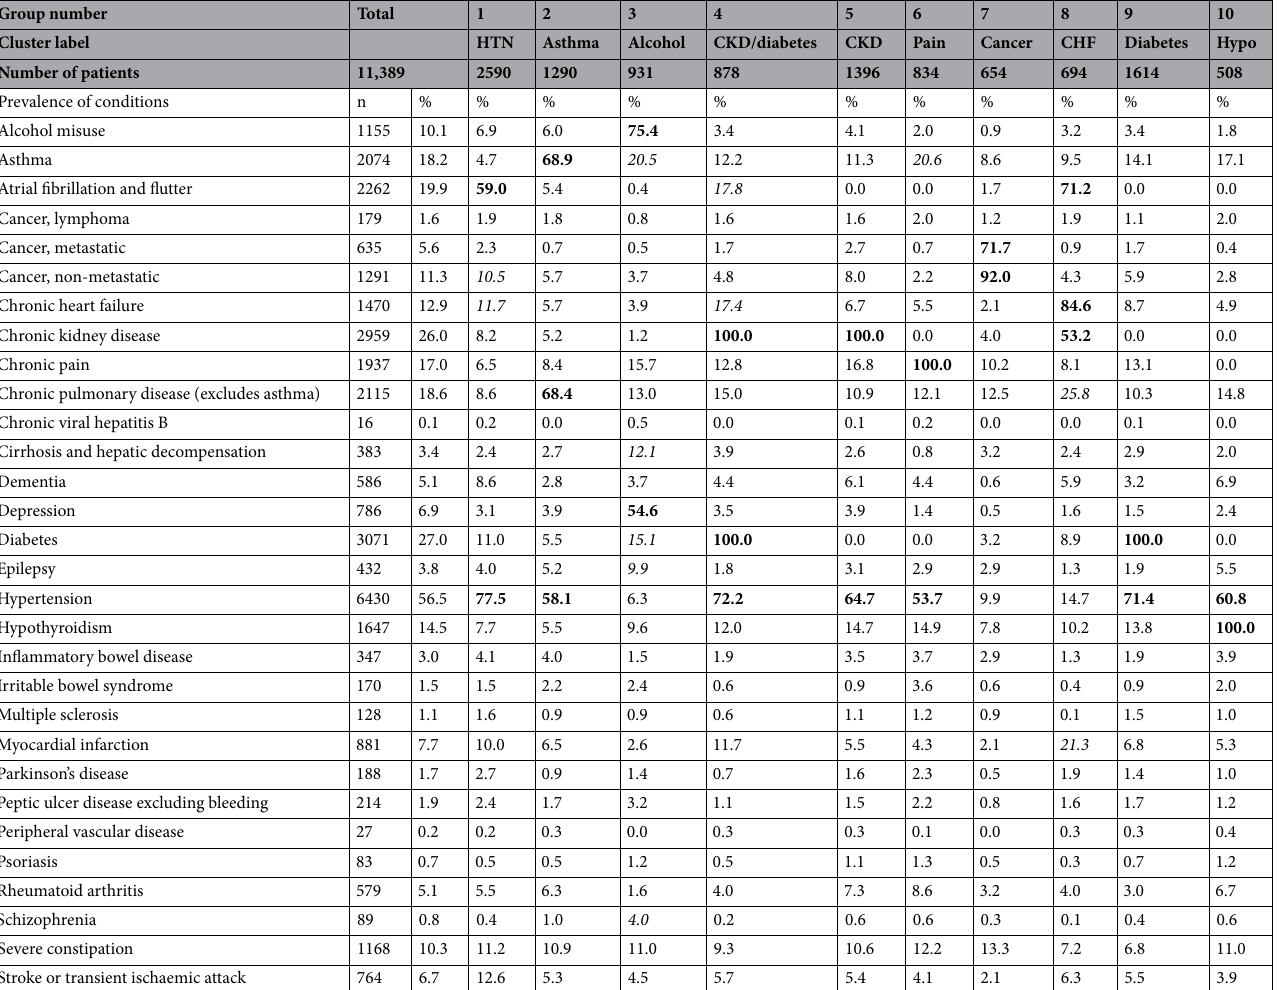
Table 3. Prevalence of 30 conditions by patient group. HTN, hypertension; CKD, chronic kidney disease; CHF, chronic heart failure; hypo, hypothyroidism. Note: Values in bold represent clusters of conditions within patient groups i.e. the highest prevalence conditions within patient groups. Values in italics represent other conditions that feature in a patient group i.e. less common conditions with a higher prevalence than in other groups.